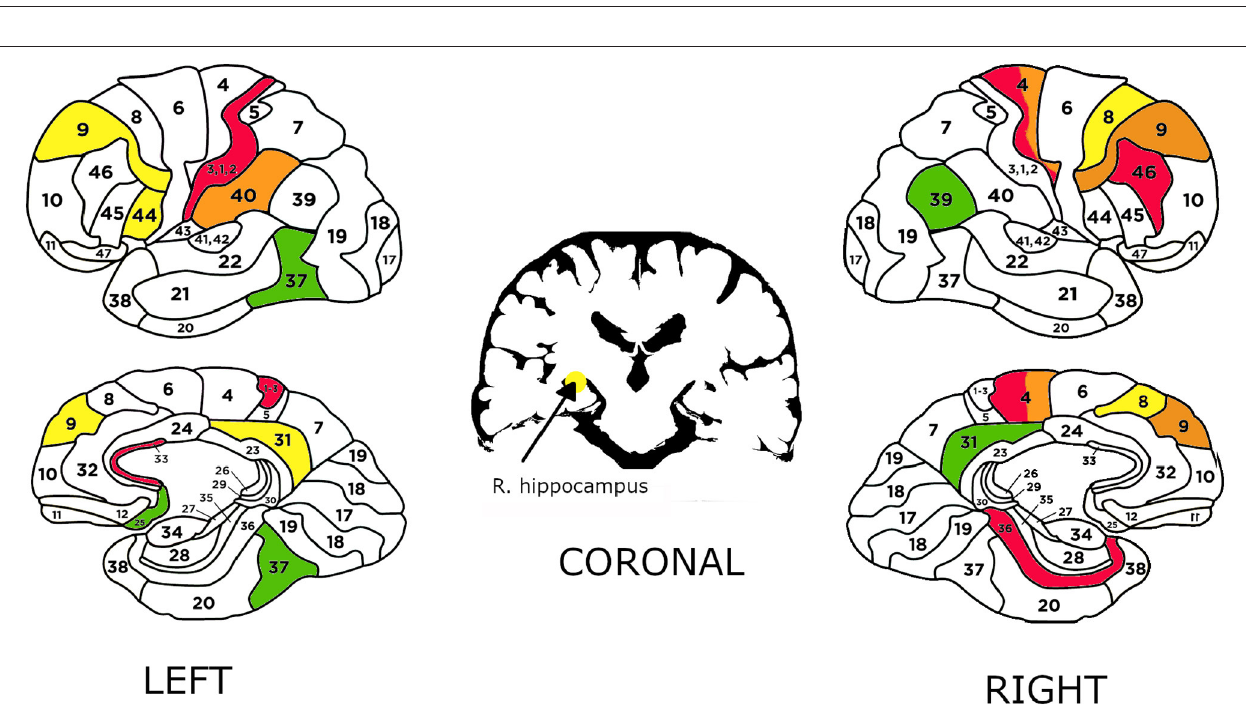
FIGURE 7 | Brodmann areas (left and right view) and hippocampus (coronal view) used in the best classifiers. The colors: green, yellow, orange, and red correspond to the classifiers in the following order: TT and FF, LT and LF (entire population), LT and LF (long note prefered), ST and